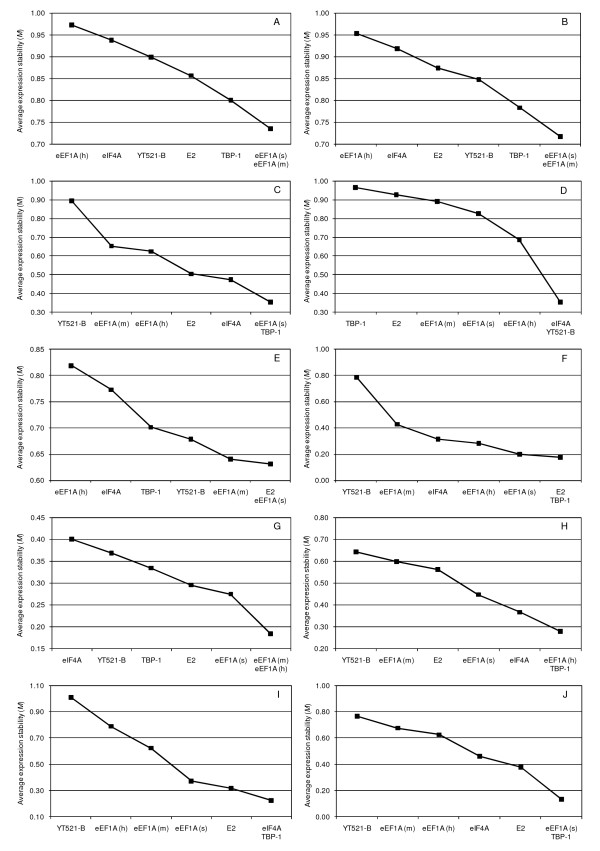
Expression stability and ranking of candidate reference genes as calculated by geNorm. (A) all 442 perennial ryegrass tissue samples, (B) 422 field-grown samples harvested following different defoliation management, (C) 13 laboratory-grown samples, (D) 218 perennial ryegrass stubble samples, (E) 220 perennial ryegrass leaf samples, (F) four perennial ryegrass callus, inflorescence and root samples, (G) five perennial ryegrass etiolated seedlings of different cultivars, (H) four field-grown samples harvested at the peak of each season, (I) three laboratory-grown samples to evaluate water stress and (J) four laboratory-grown samples to evaluate cold stress. A lower value of average expression stability (M) indicates more stable gene expression.